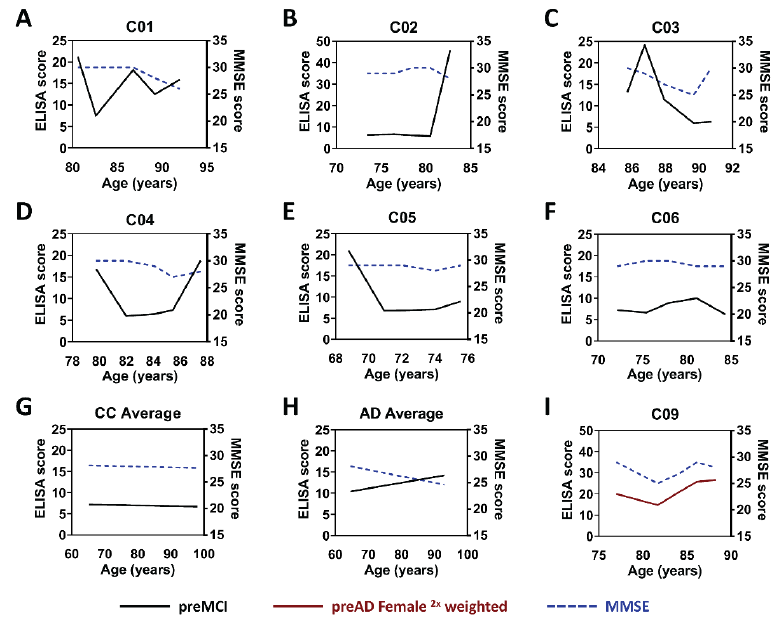
Figure 4. Time course of biomarker reactivity and MMSE scores for six flagged control cases. The preMCI biomarker panel scores (black) and MMSE scores (blue) were plotted as a function of